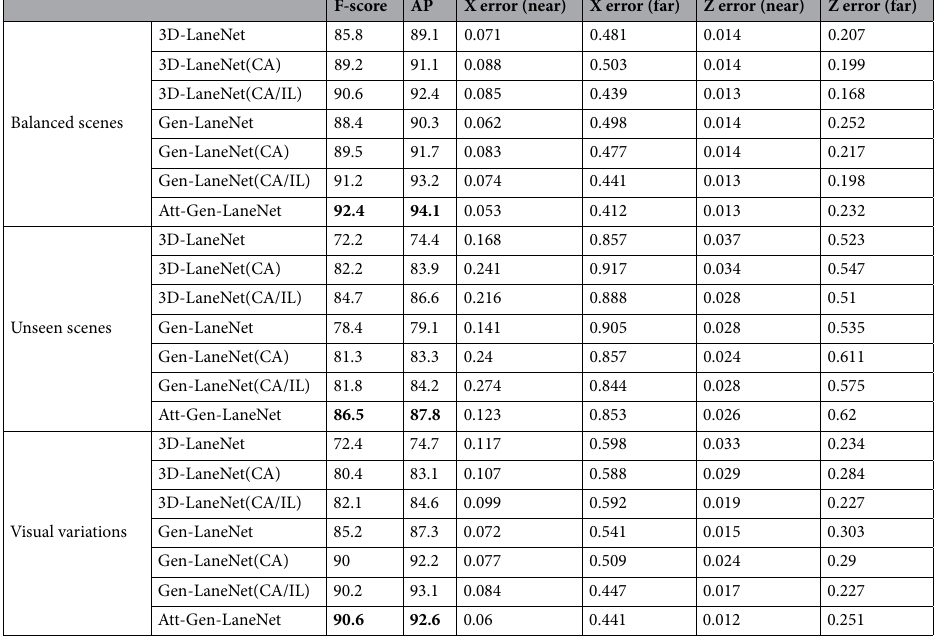
Table 2. Comparison of the generalization performance of three dataset division strategies. Significant values are in